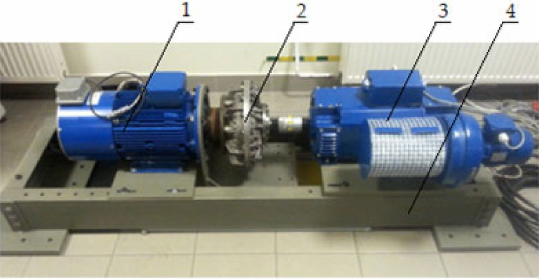
Figure 7. The mechanical part of the test rig. 1 = the AC drive motor, 2 = the hydrodynamic clutch, 3 = the DC brake motor and 4 = the